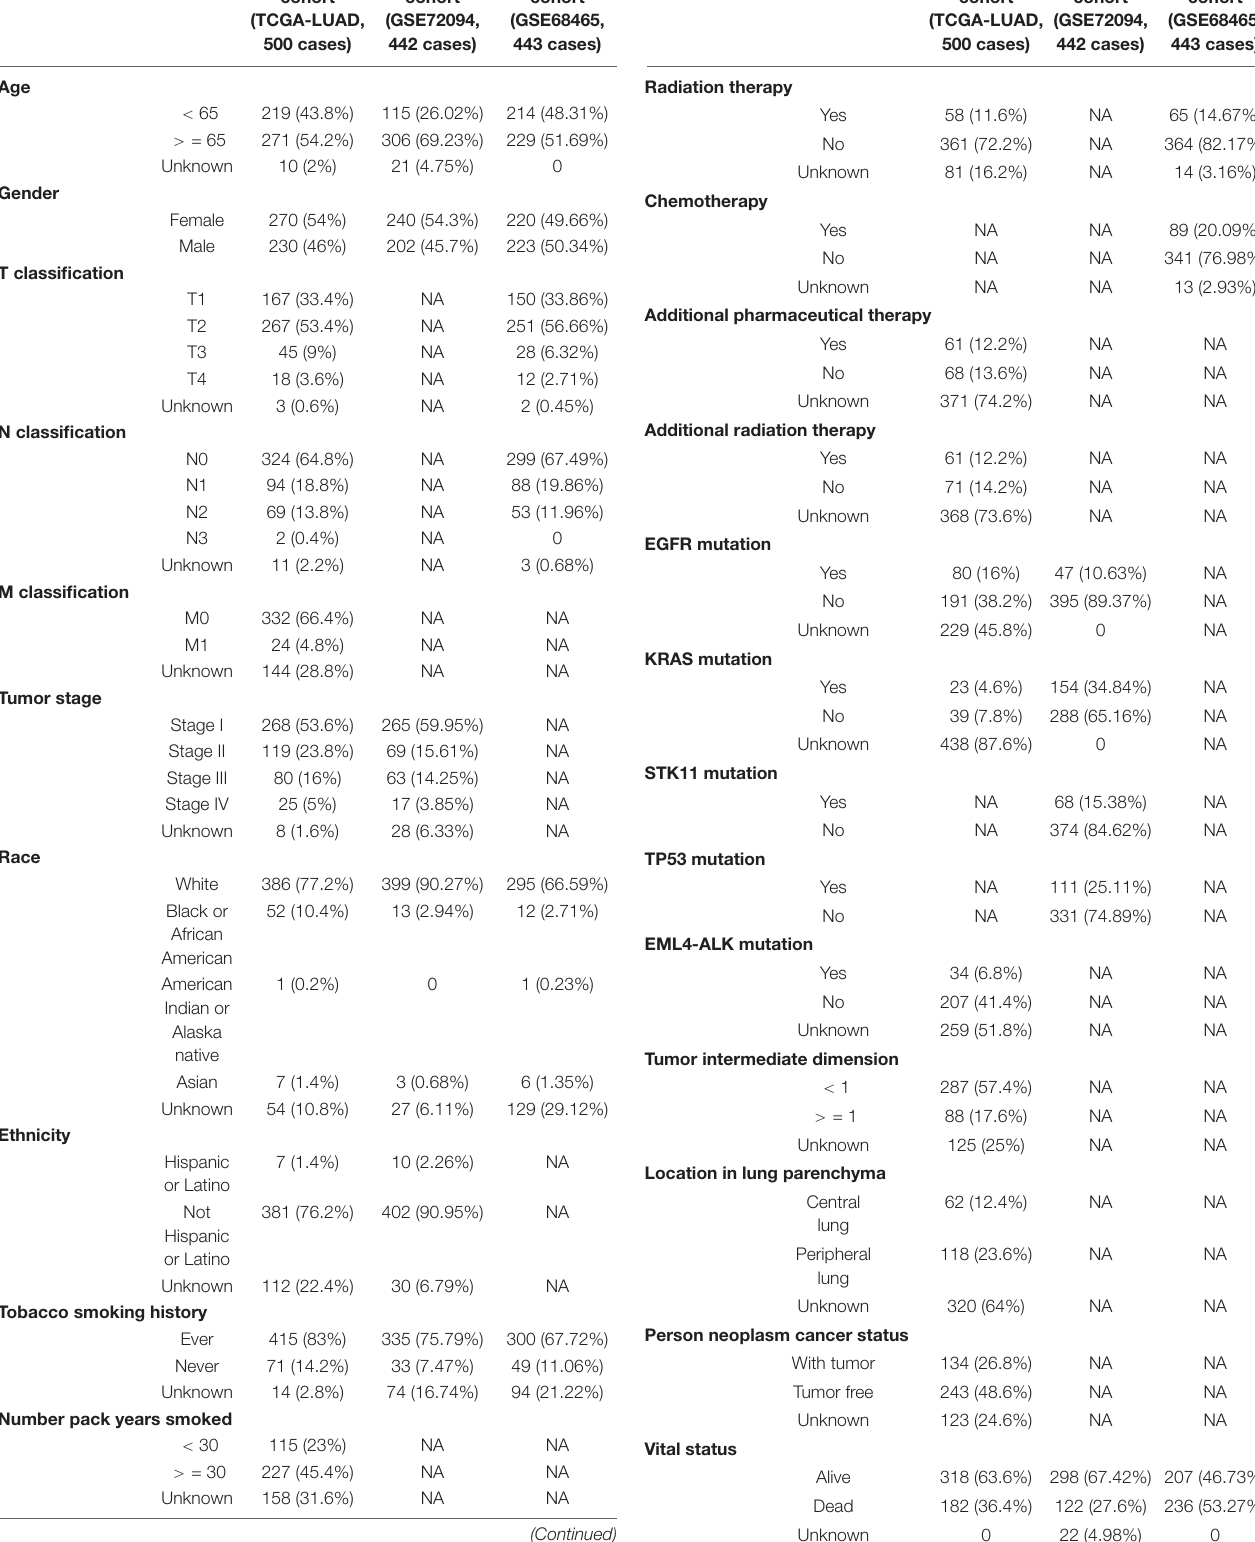
TABLE 1 | Clinical characteristics of patients involved in the